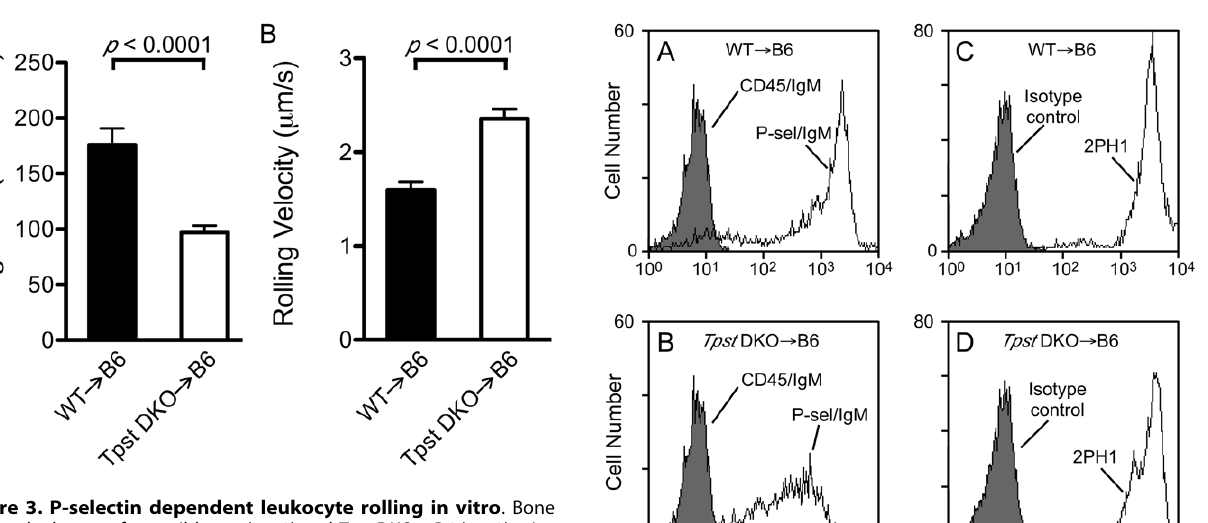
Figure 3. P-selectin dependent leukocyte rolling in vitro . Bone marrow leukocytes from wild type (n=3) and Tpst DKO R B6 (n=3) mice were isolated and their rolling on immobilized mouse P-selectin/IgM (site density =100 sites/ m m 2 ) was observed at 1 dyn/cm 2 . (A) For each animal, the number of rolling cells in 4 fields of view were averaged. (B) Rolling velocities of 10 leukocytes were determined in the same 4 fields of view as the number of rolling cells. Values are reported as mean 6 S.E.M.